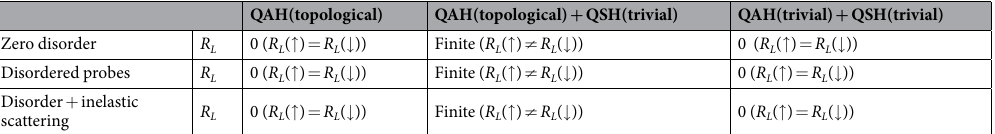
Table 2. Comparison of chiral(topological) QAH edge mode, chiral(topological) QAH edge mode with trivial QSH edge modes and chiral(trivial) QAH edge mode with trivial QSH edge modes, see also Fig. 8(a,b). Note: In the 6T QAH sample depicted in Fig. 7 the magnetization direction is ( ↑ ) implying the QAH edge mode shown by black solid or dashed line is spin-up polarized. The conductance matrices depicted in Eqs. 17, 20 and 24 as well as the calculations shown in Eqs. 18–19, 21–23, 25–27 and the longitudinal resistances derived and plotted in Fig. 8 are therefore for magnetization ( ↑ ). We follow similar procedure to calculate the longitudinal resistance for magnetization direction ( ↓ ) in which case the QAH edge modes shown by black solid or dashed lines in Fig. 7 will be spin-down polarized and mention the results in this